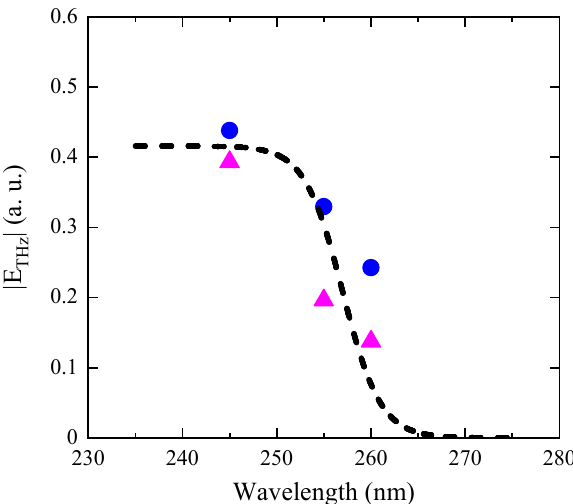
Figure 5. THz emission intensities at different wavelengths. Closed circles and triangles are for #UID-1 and #FeD, respectively. The dashed line is the calculated fit by Equation (3).